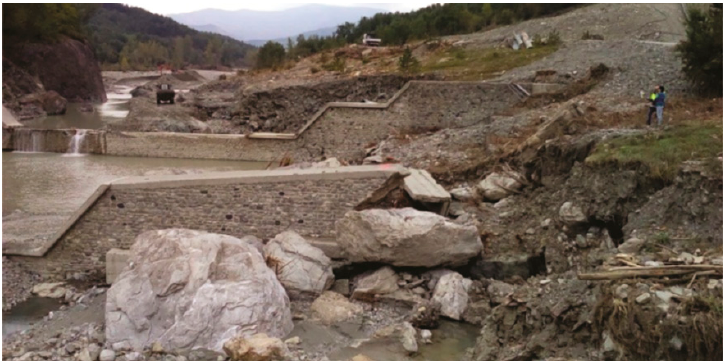
Figure 11. The Sassi Neri check dam after the flood event (from downstream). The flow circumvented and damaged the structure on the left.